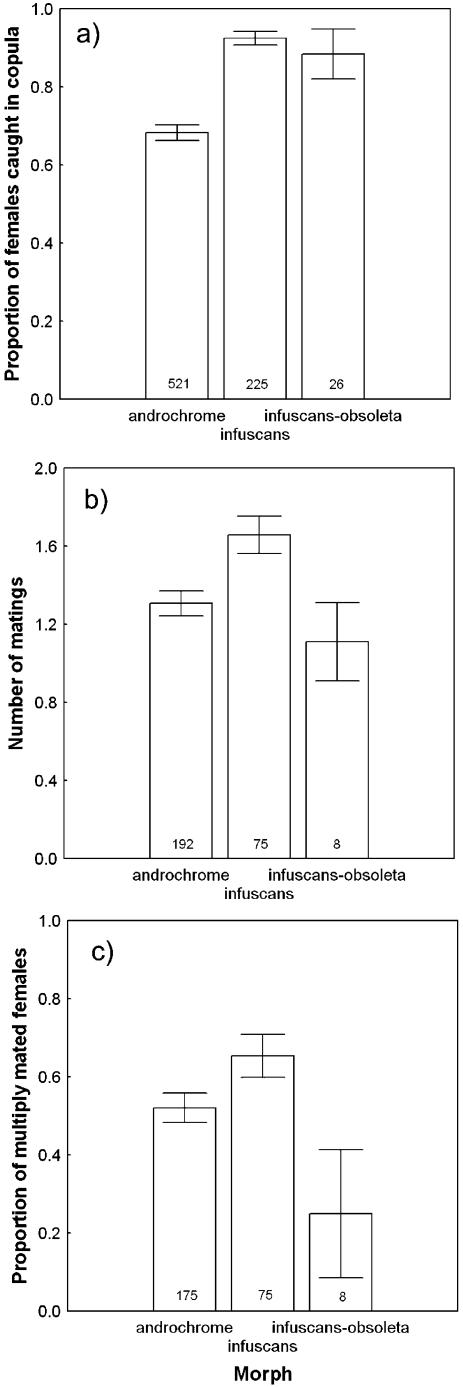
Differences in mating behaviour between three female colour morphs.a) Proportion of females caught in copula in the field ±SE (χ2 = 60.229, d.f. = 2, P = <0.001; N = 772). b) Average number of matings obtained by each morph ±SE (F2,269 = 4.014, P = 0.019; N = 275). Infuscans-obsoleta was not significantly different from either morph (Tukey HSD A = 0.6202, I = 0.1551) although the sample sizes for this morph were low (N = 8). c) Proportion of multiply mated females ±SE (χ2 = 6.981, d.f. = 2, P = 0.031; N = 258). All tests remain significant if the rarest morph, Infuscans-obsoleta, is removed from the analysis.